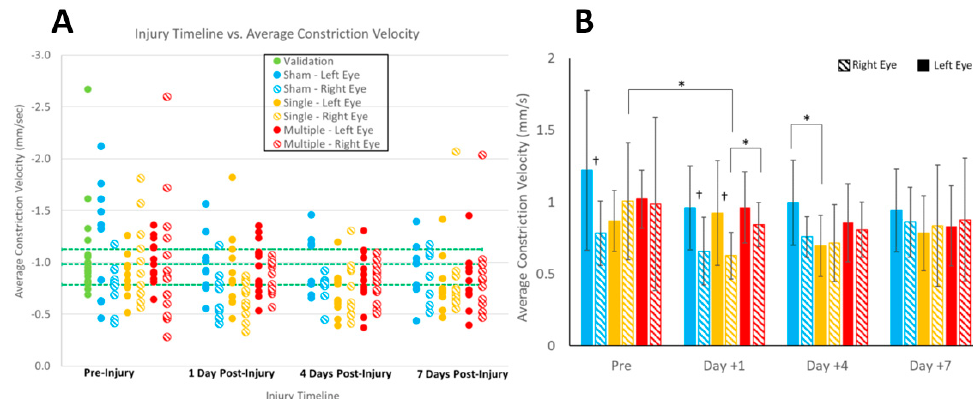
Figure 4. Proportion of validation and experimental animals in the healthy reference range ( A ) and three-way repeated-measure ANOVA for side, injury group, and study day on average constriction velocity ( B ). The effect of side was found to be significant for average constriction velocity; therefore, left and right eye data are plotted ( B ). Blue bars represents sham, yellow bars represents sRNR, and red bars represents rRNR groups. The healthy RR is demarcated with green dotted lines in ( A ). Overlaying cross bars show significant comparisons with * p < 0.05. † in ( B ) illustrates significant differences between left and right eyes ( p < 0.05).